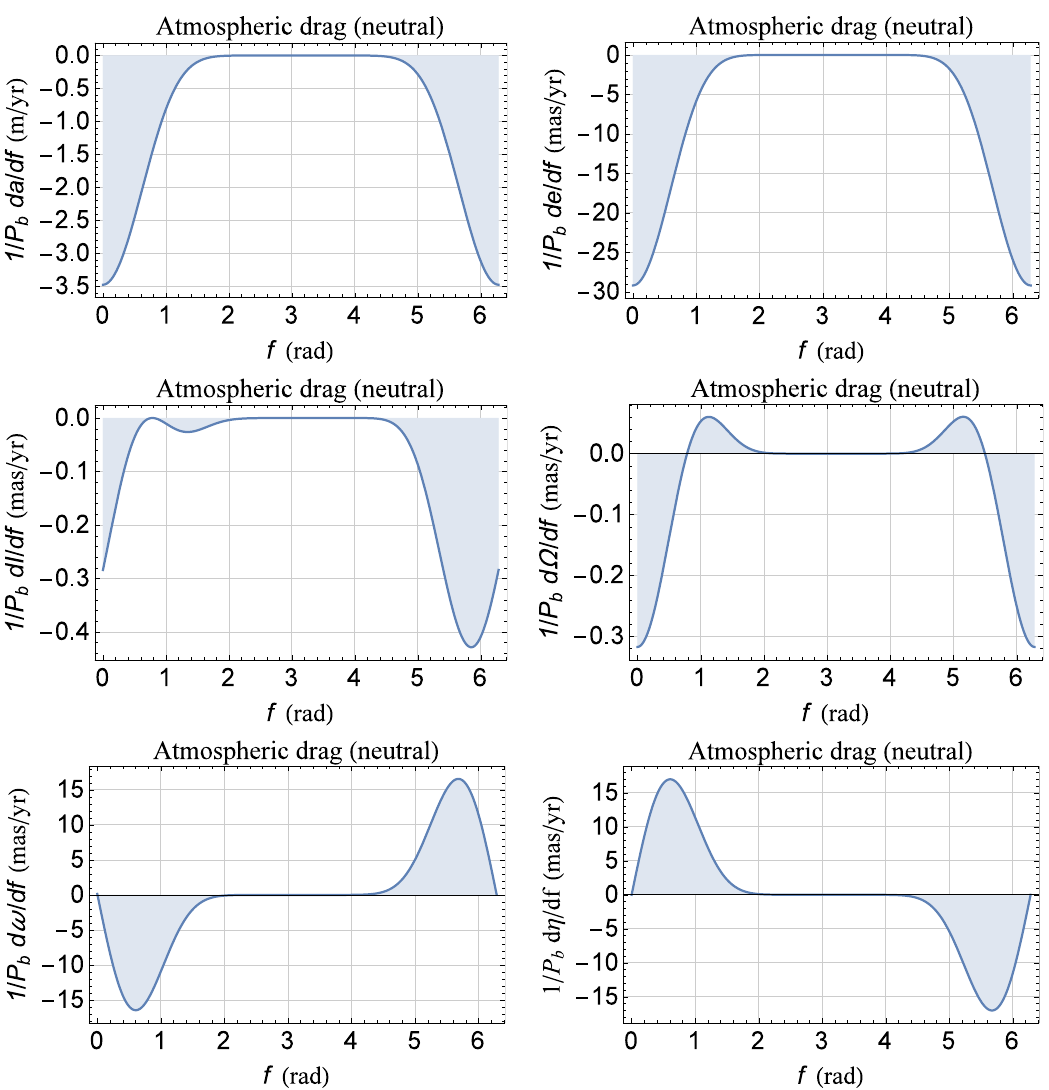
Figure A1. Plots of Equations (A49) and (A54) as functions of the true anomaly f from 0 to 2 π for the orbital configuration of TableA2. For the satellite, assumed spherical in shape and passive, we adopted C D = 3.5, Σ = 2.69 × 10 − 4 as for the existing LARES [53]. In regard to the Earth’s atmospheric density, we adopted r 0 = r min = a ( 1 − e ) = 1046.86km, ρ 0 = ρ max = 7.3 × 10 − 15 kgm − 3 , λ = 872.87km. . = Ψ / n Neither approximations in e nor in ν b were used. The areas of the regions delimited by the curves and the f axis are the rates of change of the orbital elements averaged over one orbital period P b ; they are numerically calculated and displayed in Table A5. The value of ρ 0 = ρ max was kept fixed over one orbital